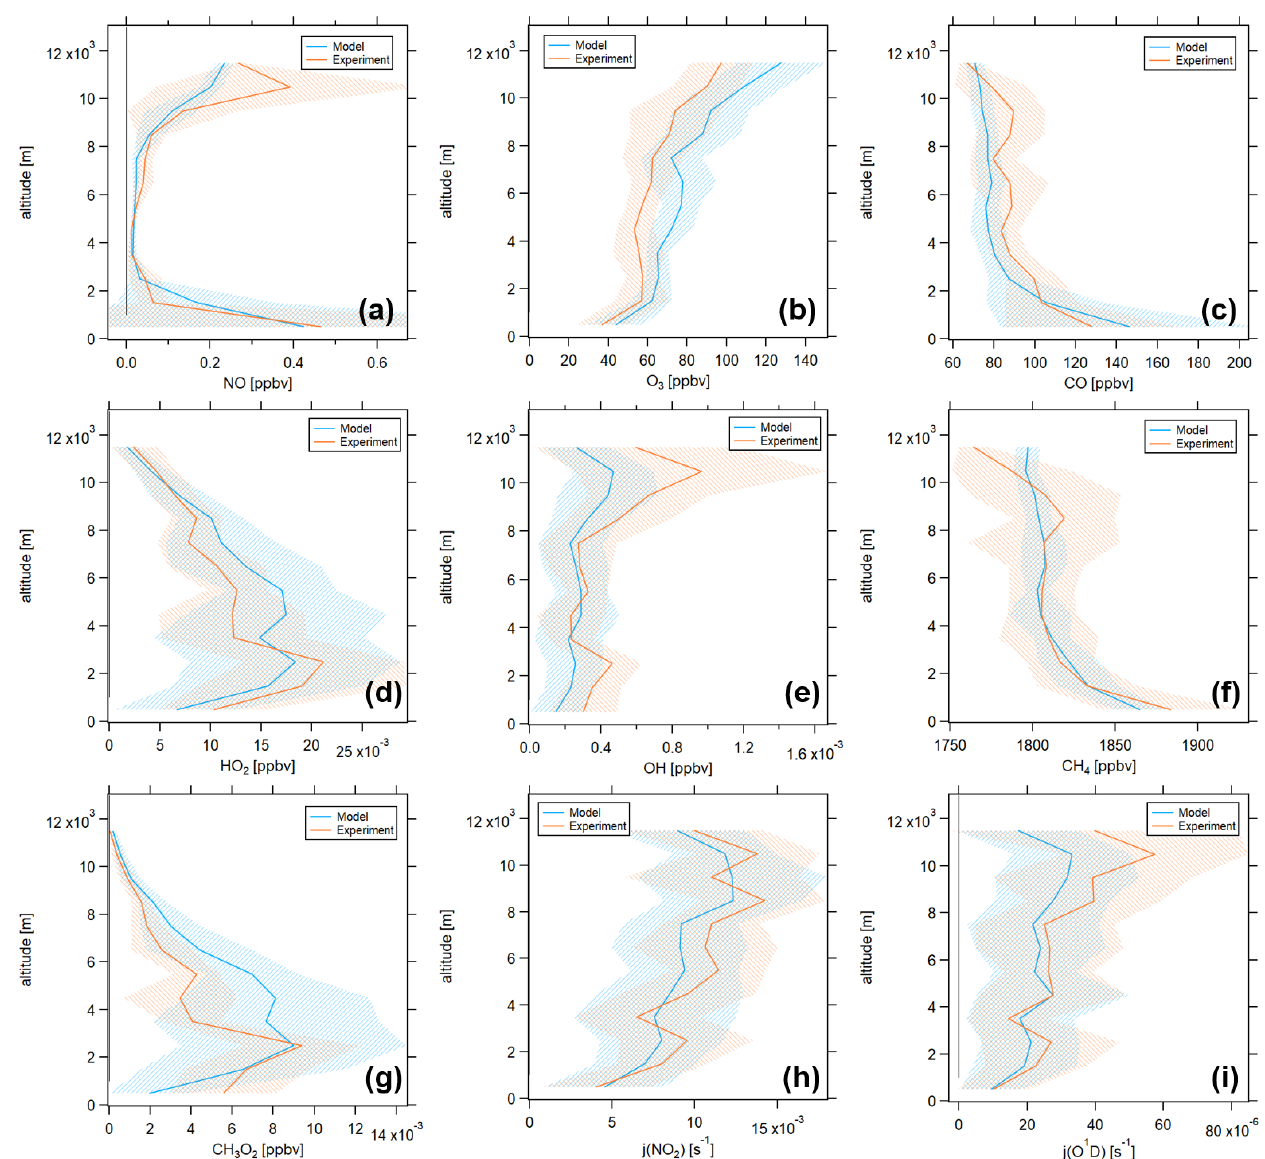
Figure 2. Vertical profiles of in situ observations and model data of the atmospheric trace gases (a) NO, (b) O 3 , (c) CO, (d) HO 2 , (e) OH, (f) CH 4 and (g) CH 3 O 2 and the photolysis rates (h) j (NO 2 ) and (i) j (O 1 D) during the HOOVER campaign for estimating the model perfor- mance. Blue colors show modeled data by EMAC along the HOOVER campaign flight track (model) and orange colors show experimental data (experiment). The orange trace in panel (g) shows the calculation of CH 3 O 2 from experimental CH 4 , CO and HO 2 via Eq. (3). The shaded areas represent the 1 σ standard deviation from averaging the data points at each altitude bin. The numbers of data points averaged per altitude bin are displayed in Tables S1 and S2 in the